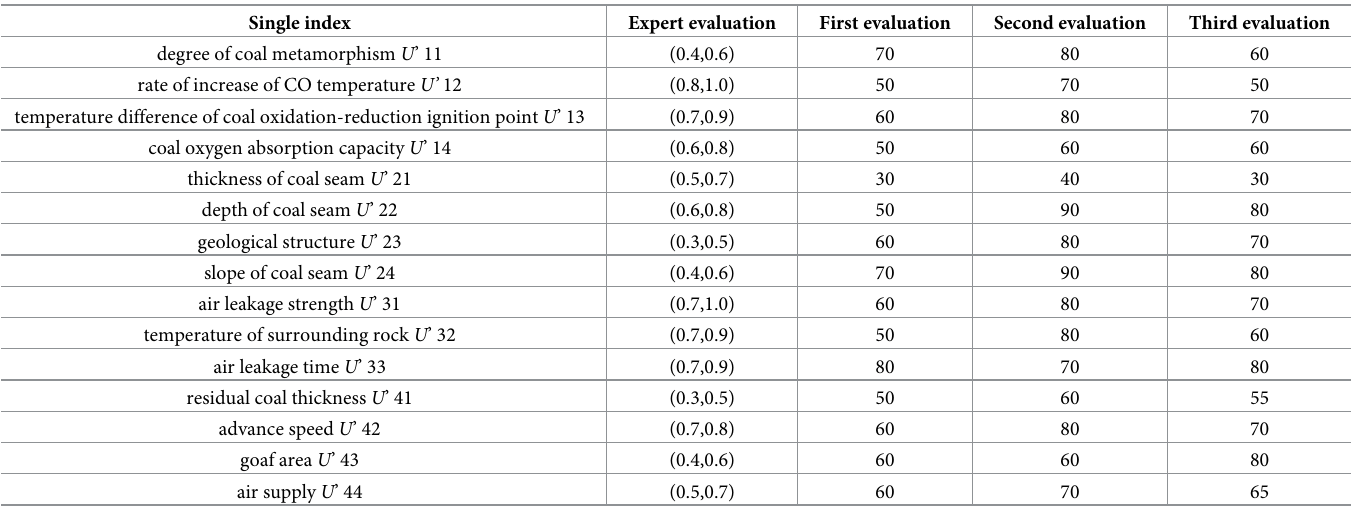
Table 3. Expert scores and improved indicator scores.